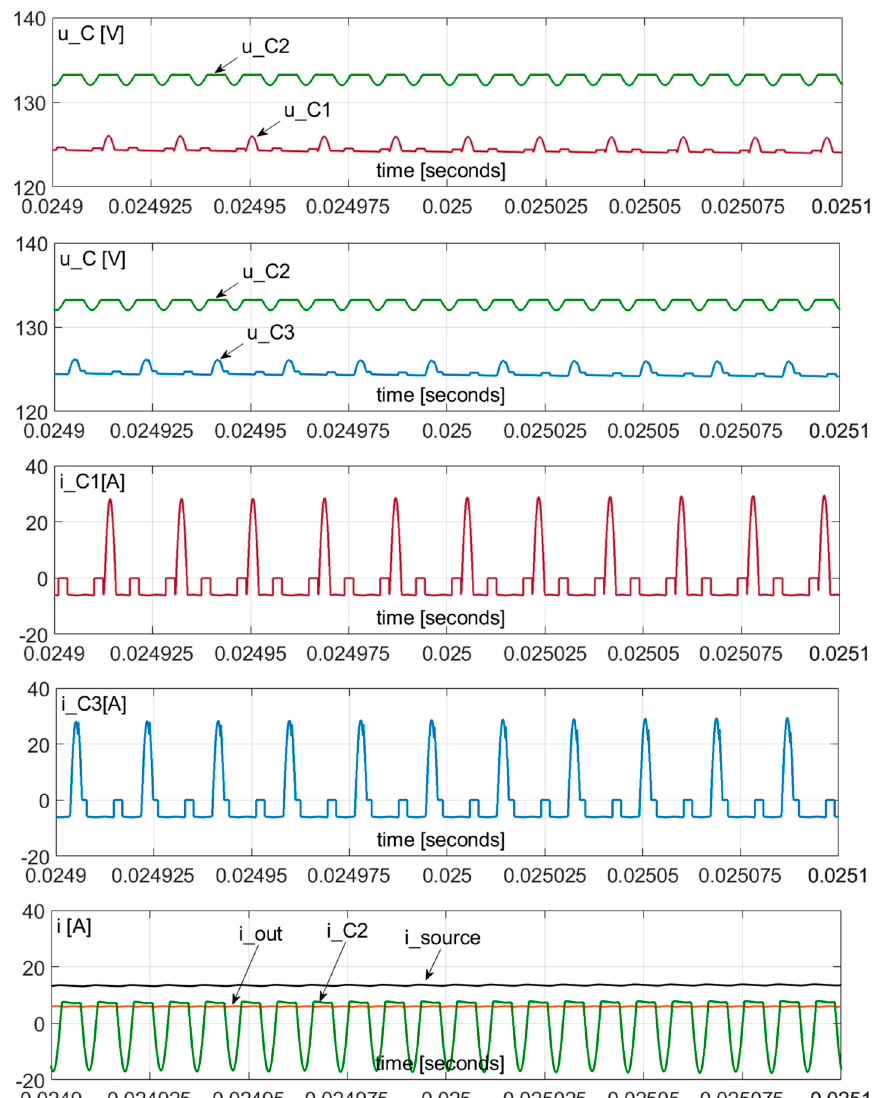
Figure 7. Steady state waveforms of DC-AC system (Figure 1) with the AIVB operating with con- stant frequency. The output voltage, the load voltage and current, voltages and currents of DC-link capacitors and the source. 5 ms/div, P out = 1 kW, L f = 6 uH.